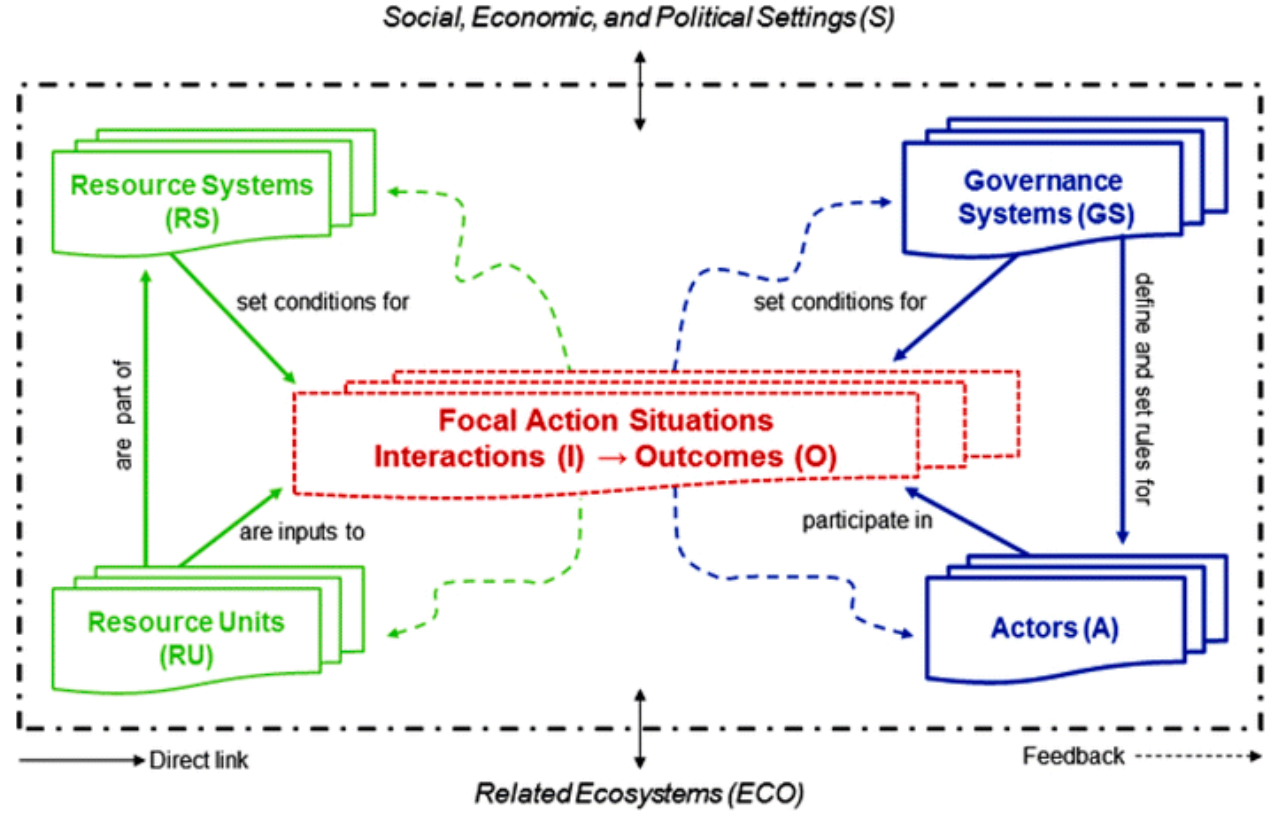
Figure 1. SES framework. Table 1. Second-level variables of the SES